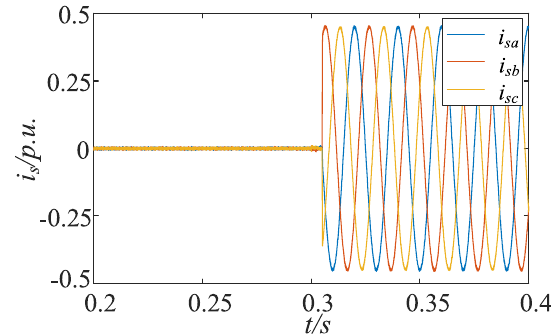
Fig. 17 Three-phase grid-connected current when the voltage drops under no-load